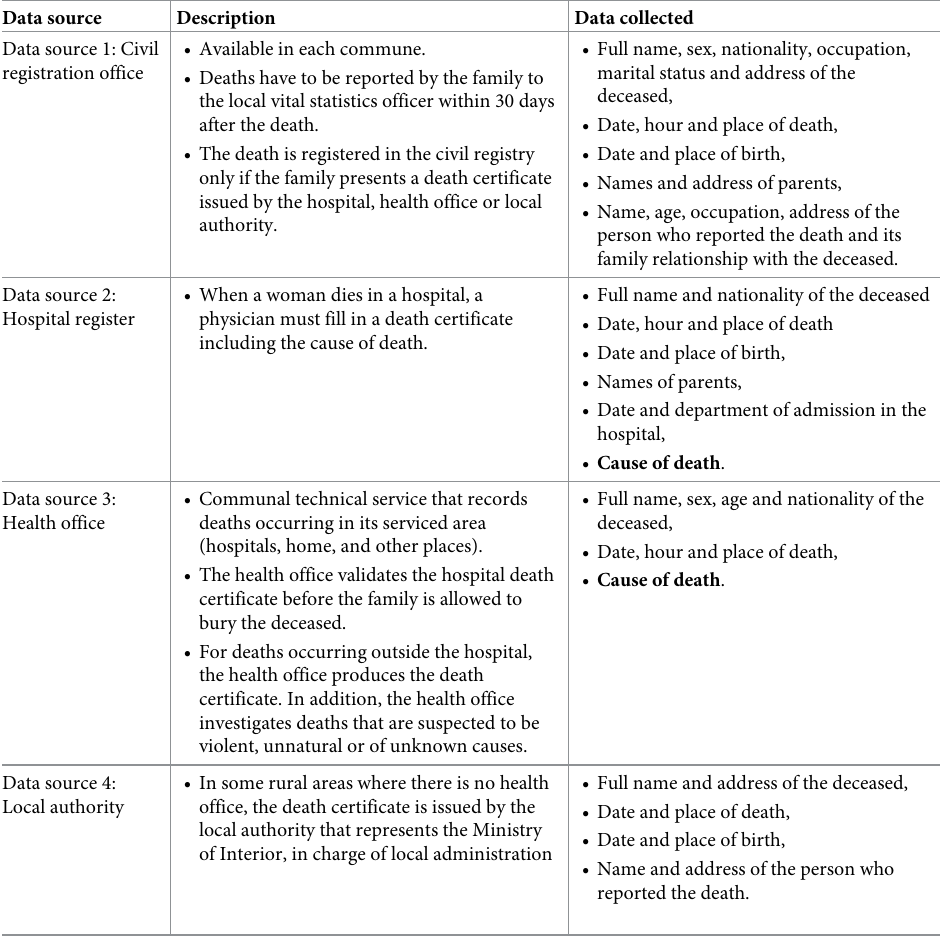
Table 1. Data sources in GCBH